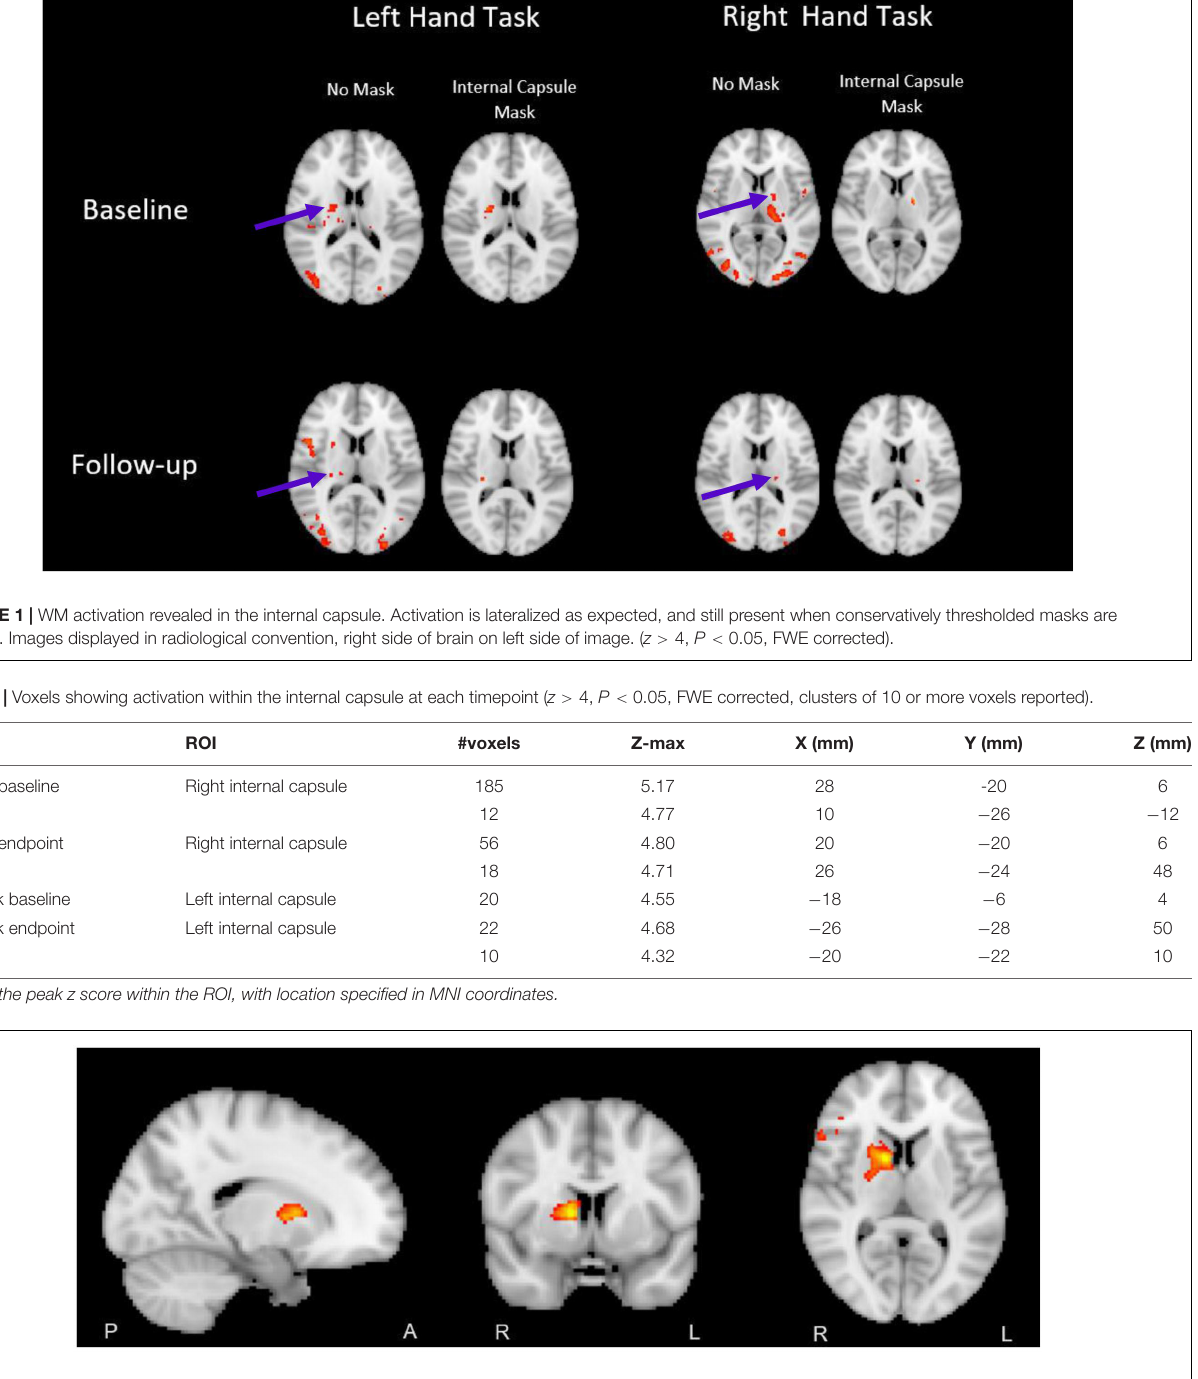
FIGURE 2 | Right internal capsule showing greater HRF dispersion at group level, baseline > endpoint ( z > 2.5, p < 0.05, FWE corrected). No mask applied.